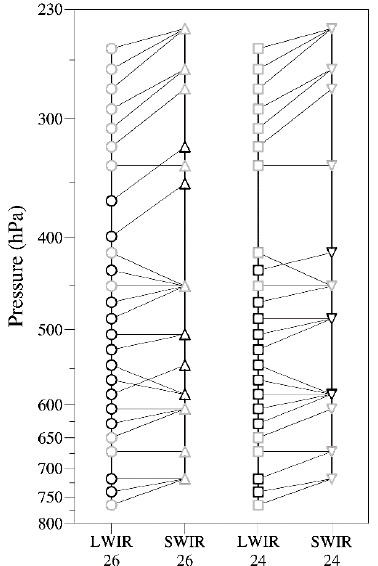
Figure 6. Vertical distribution of LWIR (circle and square) and SWIR (upward-pointing triangle and downward-pointing triangle) peak WF of 26 (modified method) and 24 (original method) pairs. Grey markers indicate the same paired LWIR and SWIR